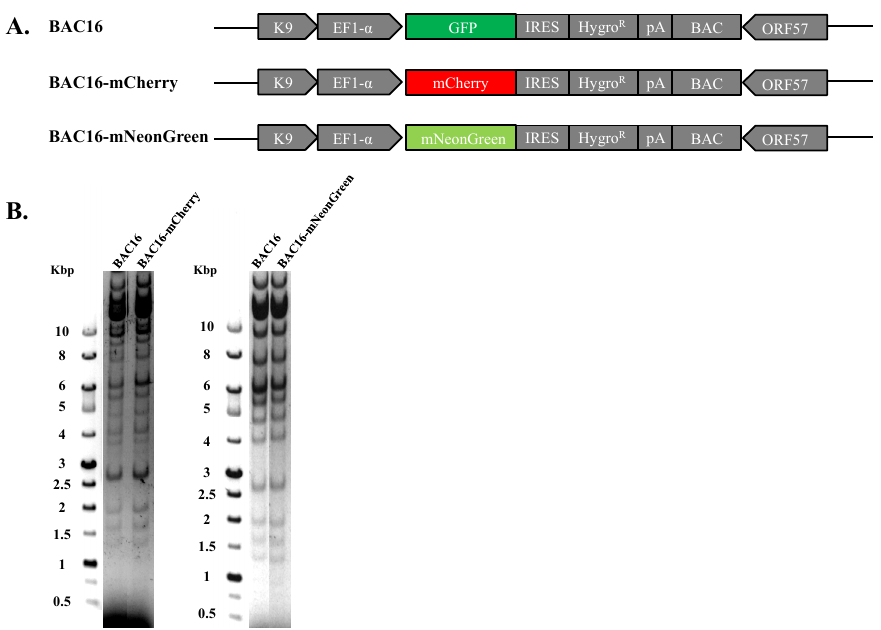
Figure 1. Construction and analysis of BAC16-mCherry and mNeonGreen KSHV recombinant genomes. ( A ) Schematic illustration of the parental KSHV BAC16 genome as well as BAC16-mCherry and BAC16-mNeonGreen genomes. ( B ) Agarose gel electrophoresis of BAC16, BAC16-mCherry, and BAC16-mNeonGreen. DNAs were digested with BglII, resolved on a 0.4% agarose gel, and stained with ethidium bromide. Molecular weight markers are shown on the left. BAC16-mCherry and BAC16-mNeonGreen display similar digestion pattern as that obtained for the corresponding BAC16 DNA.